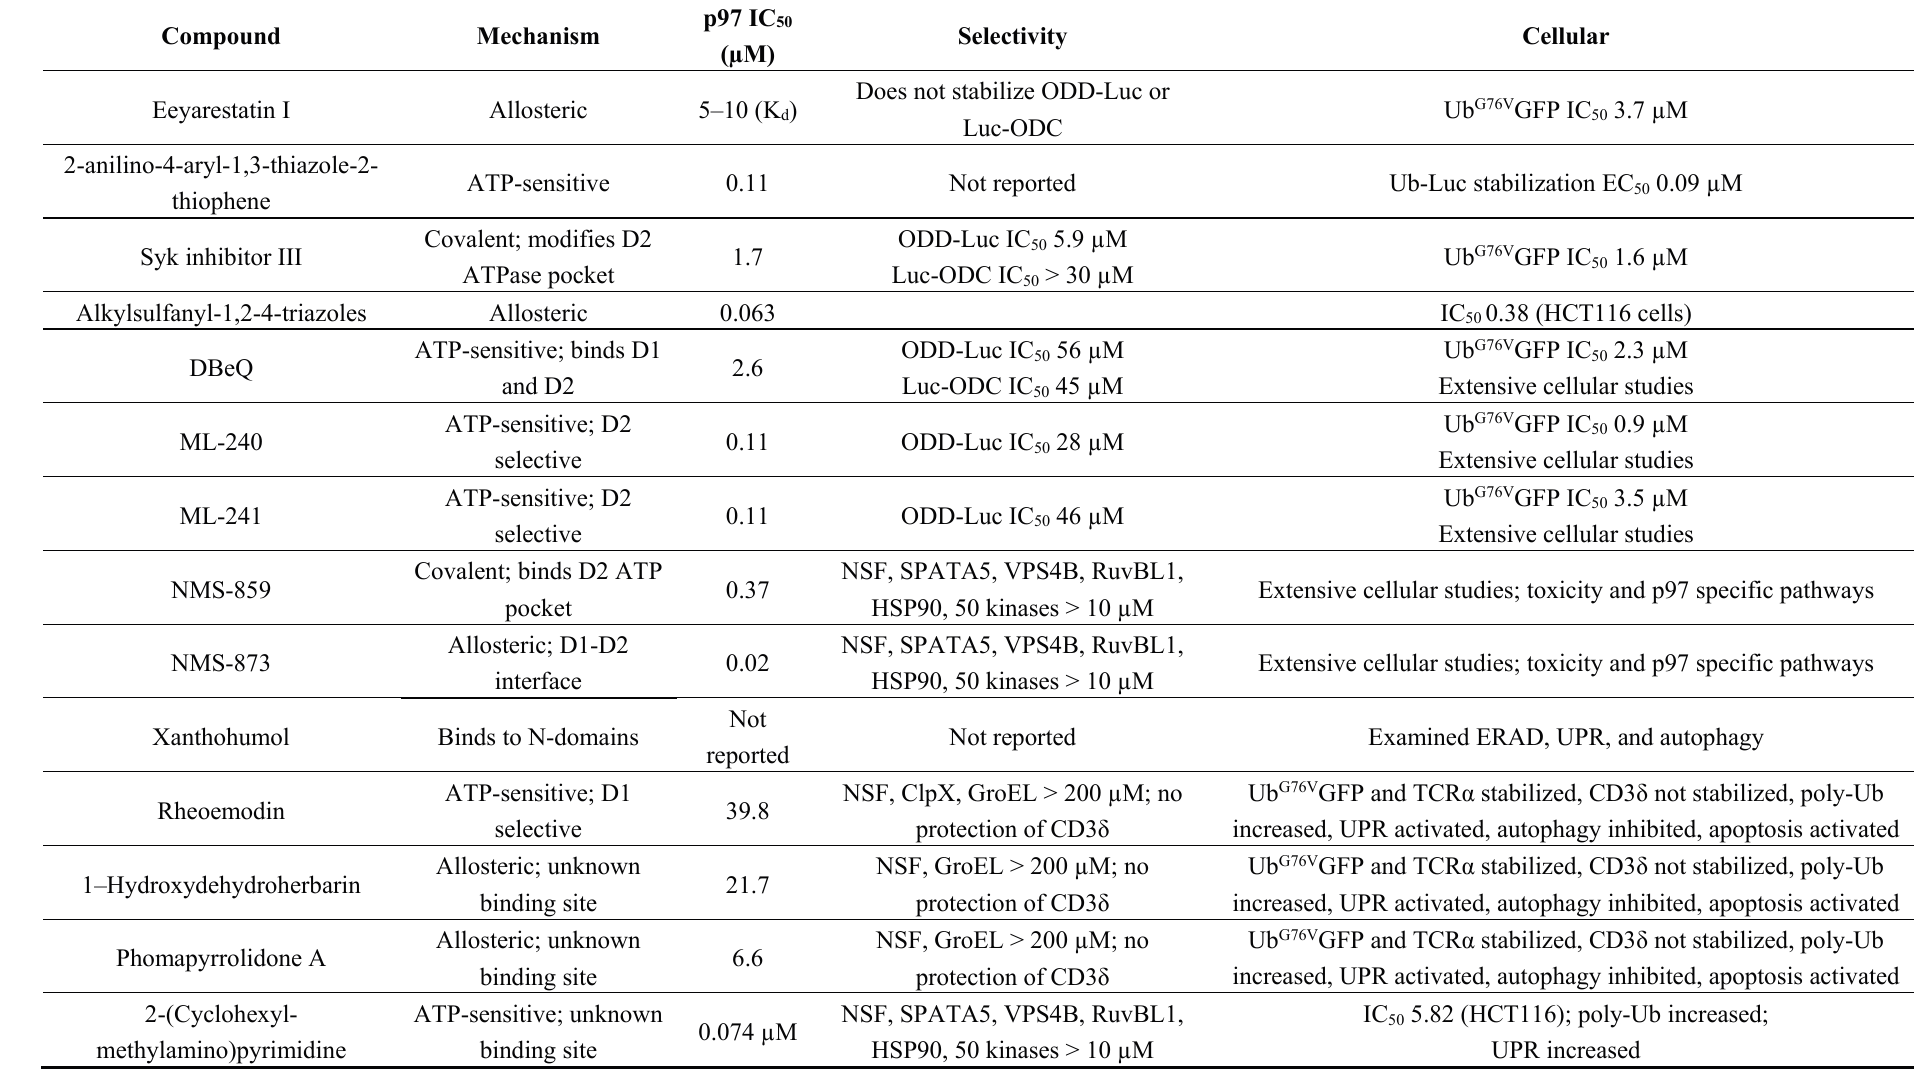
Table 1. Compounds discussed in the present